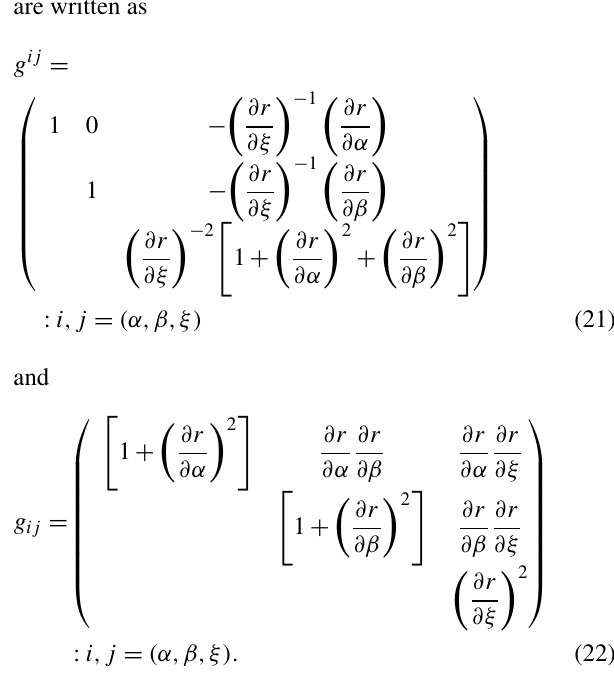
each element, levels are placed at the n vp Gaussian quadra- ture nodes and interfaces at n vp + 1 Gauss–Lobatto quadra- ture nodes, leading to a staggering of levels and